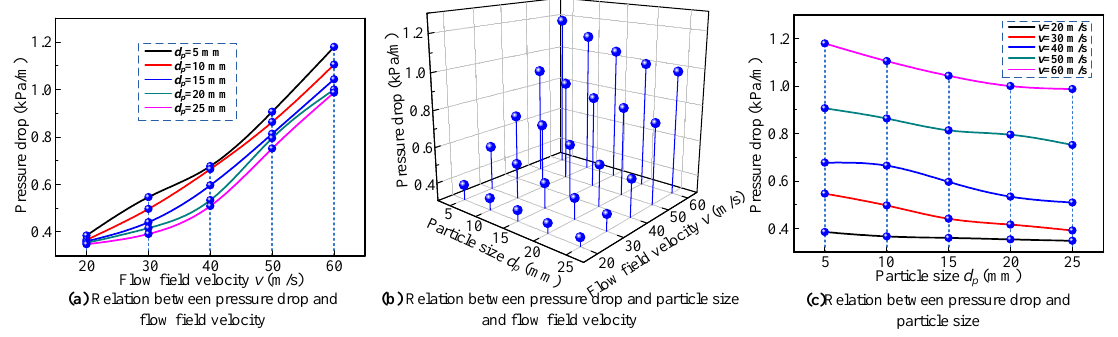
Figure 3. Relationship between pressure drop, particle size and flow field velocity.